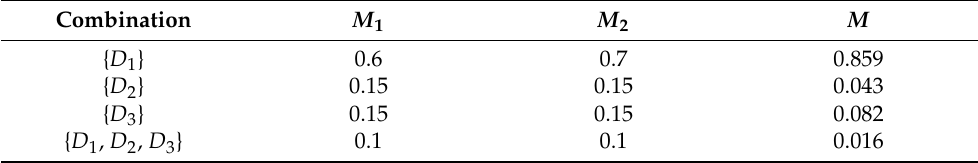
Table 8. The BPA of each combination.